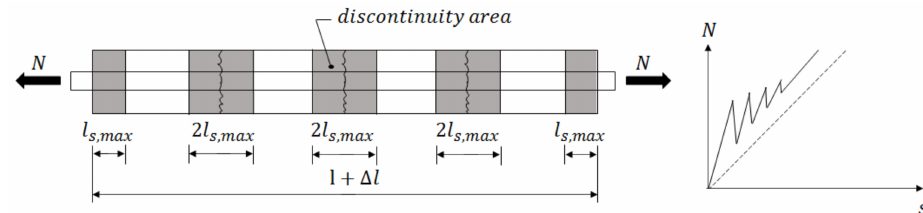
Figure 12. Behavior of a reinforced prismatic bar subjected to imposed deformation. Adapted by [47].